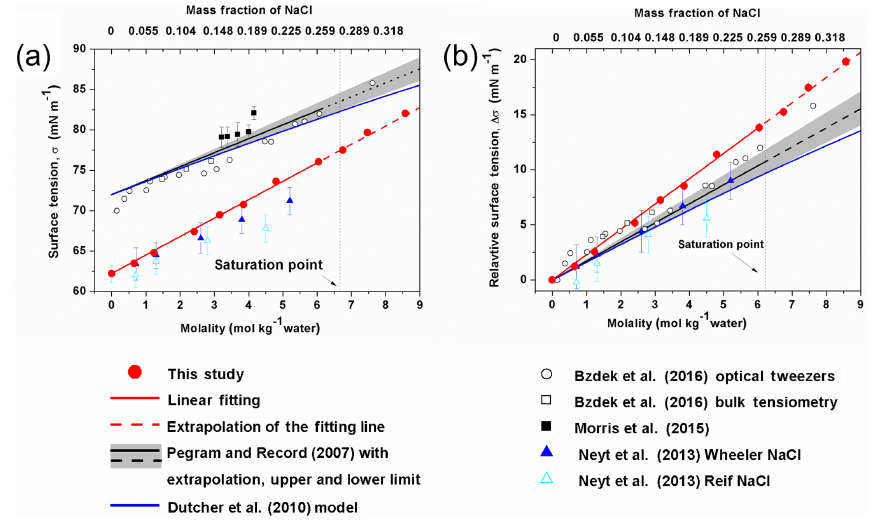
Figure 3. Surface tension (a) and relative surface tension (b) defined as (cid:49)σ = σ solution − σ water as a function of the concentration of NaCl. The σ water in the Morris et al. (2015) study was not determined, thus the corresponding (cid:49)σ is not shown in (b)